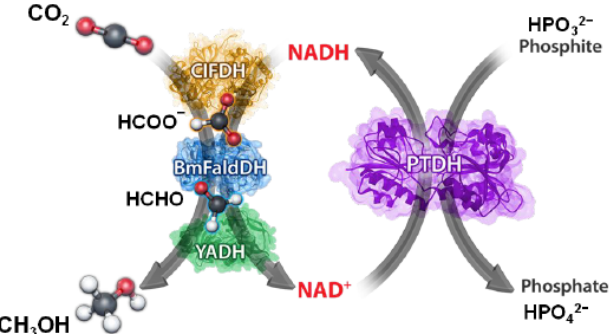
Figure 3. Schematic illustration of CO 2 reduction coupled to enzymatic cofactor regeneration. Reprinted with permission from ref. [64]. Copyright © 2022 American Chemical Society.